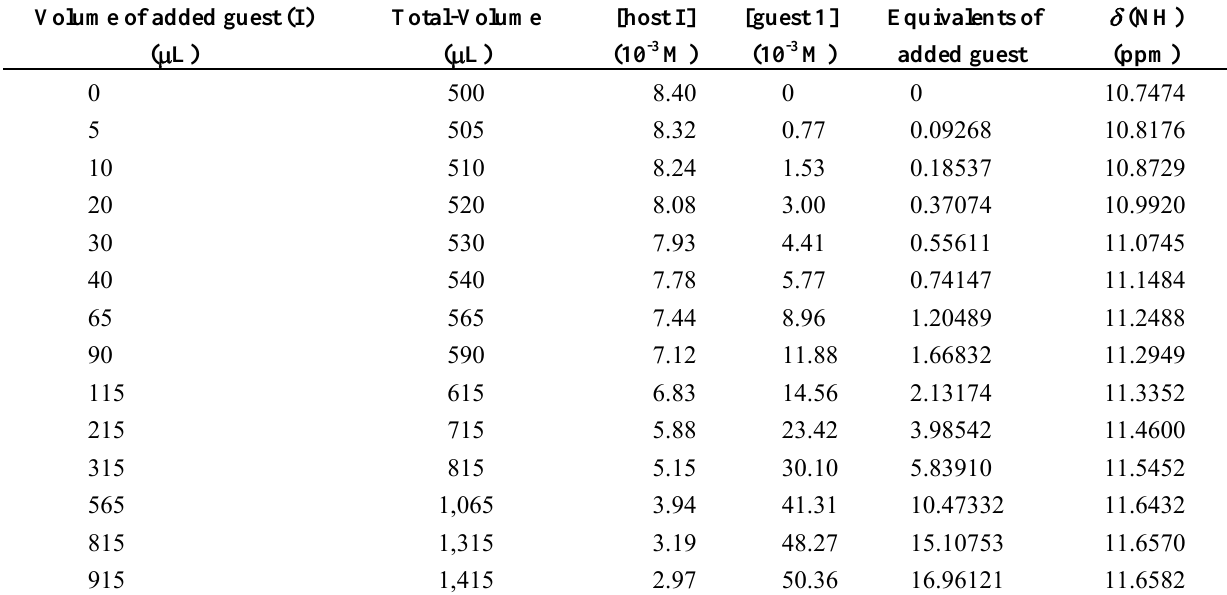
Table 3 . Representative table for a Saturation Titration conditions ( ST ) of host I with ( + )-